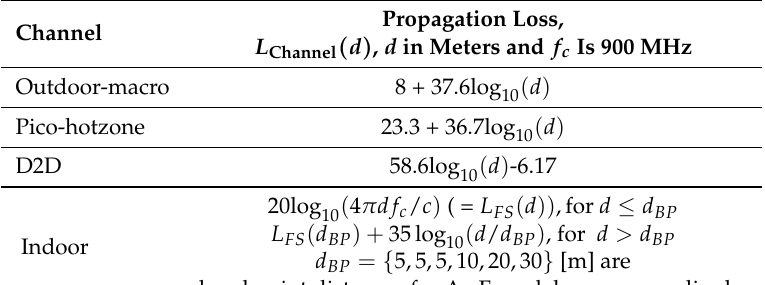
Table 3. Propagation loss in decibels for different channels [56].